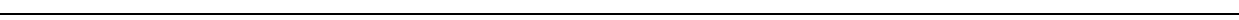
Fig. 1 Subspecies found in the infant gut across several cohorts and years are also present in rooms. Fecal (columns 1, 2, 3, and 5) and room (column 4) samples from de fi ned sampling time periods (the 2011, 2012, 2013, and 2014 cohorts) are arrayed on the x axis. Dots indicate the percent of infants, or rooms for column 4, in each cohort that contain a given subspecies (the top three highest percentages are labeled for clarity). The y axis labels indicate a representative genotype from clusters of genotypes that share > 99% gANI. The fi rst digit in the name indicates the species and the second indicates the speci fi c subspecies. See Supplementary Data 3 – 11 for further genome-clustering results. Only genomes that were found across different cohorts or in both an infant and a room are displayed. Triangles indicate organisms classi fi ed as persistent taxa ( “ persisters ” ) because they appear in the room and in